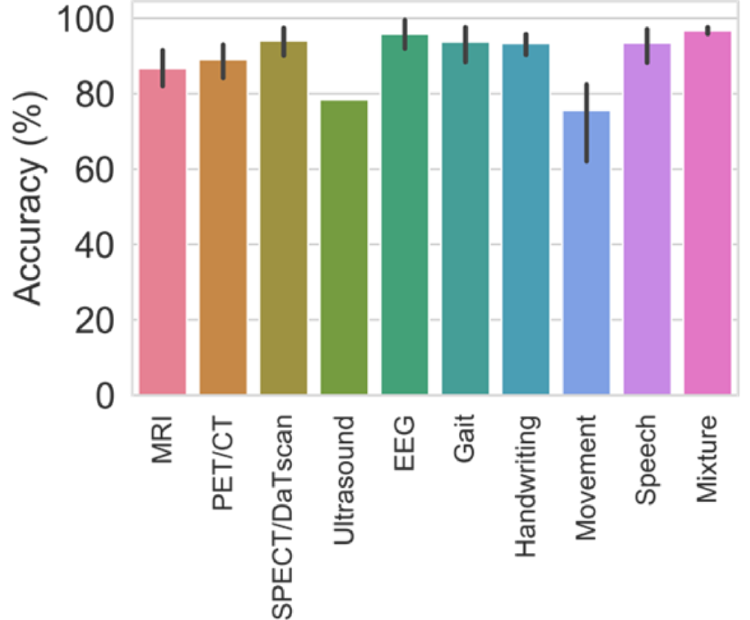
Figure 13. Bar chart representation of the average model accuracy from various deep learning studies obtained for each